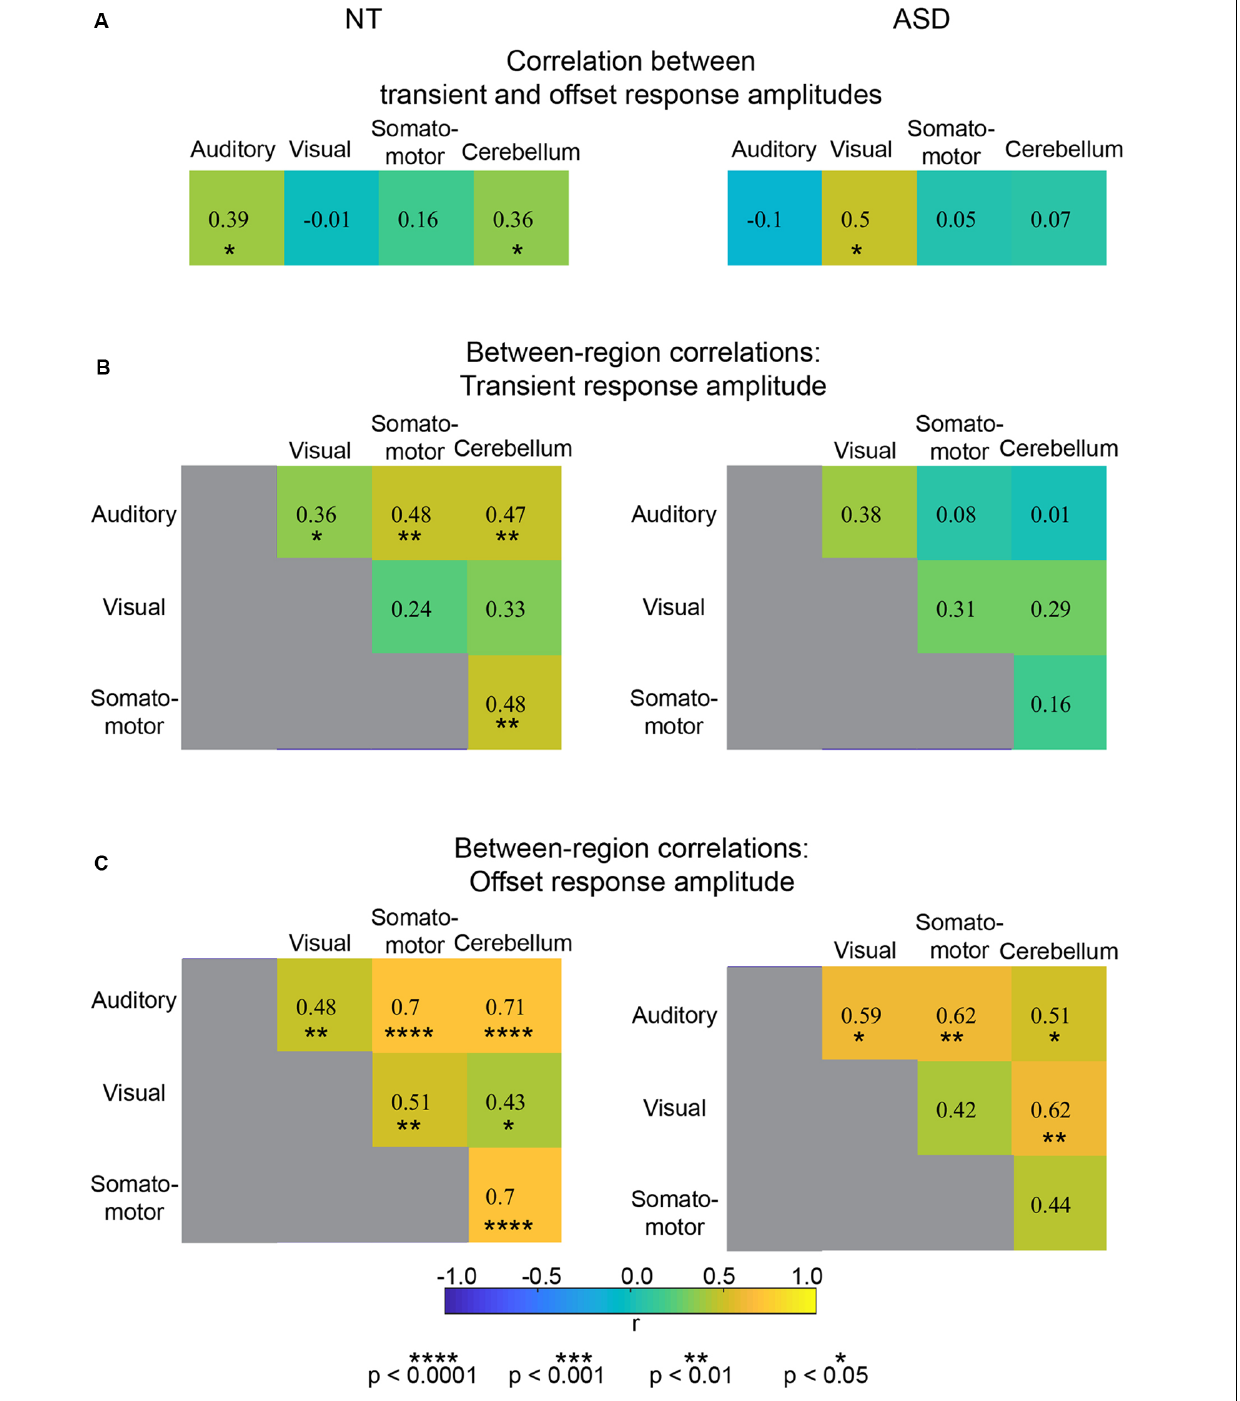
boxcar predictor for the entire stimulus block was convolved with a double gamma hemodynamic response function (HRF; parameters: time-to-response peak = 5 s;